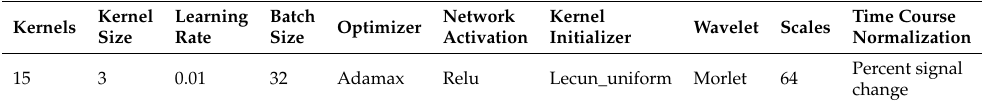
Table 2. CNN and CWT parameters.